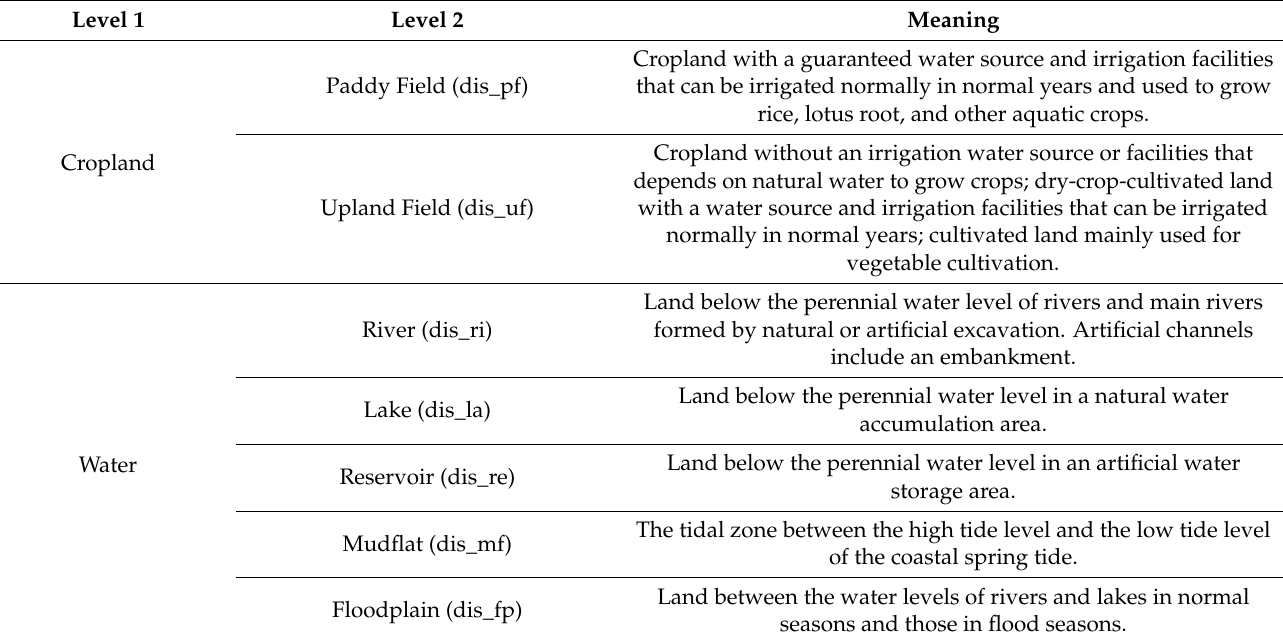
Table 2. Land use